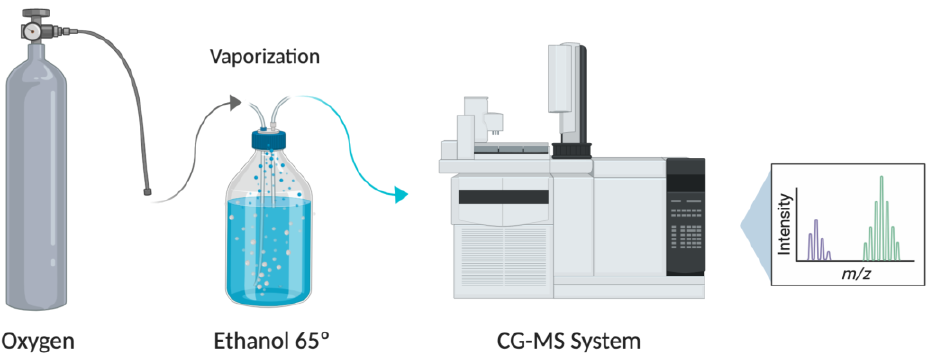
Figure 1. Diagram of the oxygen flow system and humidifier with 65° ethanol coupled to a gas chromatography mass spectrometry (GC-MS) system. Created with BioRender.com. Samples were incubated at 45 °C for 4 min, before 0.2 mL of headspace gas was with- drawn by the autosampler, using a 2.5 mL syringe heated at 50 °C. The gas volume was injected into the inlet of the Trace GC set at 175 °C in a constant temperature split mode, at a split ratio of 50:1 and the split flow of 50 mL/min. The analytical column was a Rxi- 624Sil MS, 30 m in length, with an internal diameter of 0.25 mm (1.4 μ m film thickness) from Restek (Pennsylvania, USA). Helium was used as carrier gas at a flow rate of 1.0 mL/min in a constant flow mode. The oven temperature was initially set at 40 °C for 4 min, then increased at a rate of 50 °C/min until 120 °C, and held at 120 °C for 2.5 min. The total runtime of each analysis was 10 min. The temperatures of the GC transfer line and the ion source of the MS were set at 220 °C and 200 °C, respectively. The mass spectrom- eter was operated in an electron impact ionization (EI+) mode, and the chromatograms were acquired in full scan mode over the m/z range of 20 – 150, from 2 to 10 min, at a scan rate of 3.55 scans/s. The chromatographic peak of ethanol was identified by comparison with reference spectra from the NIST 2011/Wiley 9 Combined Mass Spectral Library, us- ing NIST Mass Spectral Search Program (version 2.0), and confirmed by comparison of its retention time (3.4 min), with that obtained by analysis of authentic standard under the same conditions. The instrument control and data acquisition and processing were per- formed with Xcalibur 2.0.7 software (Thermo Fisher Scientific Inc., Waltham, MA, USA). The calibration curve of ethanol was prepared in 21.5 mL HS glass vials, which were previously sealed with Teflon septum caps, by adding different volumes of 99.5% (0.5 – 2 µL) ethanol to reach the headspace (vapor phase) concentrations in the range of 20 – 100 mg/L. The equation and determination coefficient obtained from three replicates were y = 82.285x + 9.8808 and R 2 = 0.9993, respectively. 2.3. Preclinical Studies 2.3.1. Ethanol Exposure Toxicological Studies and Immunohistochemical Analysis These studies were carried out on six female Sprague-Dawley rats (four receiving inhaled ethanol and two control rats). They were supplied by the animal facilities at the University of Santiago de Compostela, and the average weight was 250 ± 25 g. During the experiments, animals were kept in individual cages under a controlled temperature (22 ± 1 °C) and humidity (60 ± 5%) conditions, with day-night cycles regulated by artificial light (12/12 hours) and fed ad libitum . All animal experiments complied with the ARRIVE guidelines [31] and were carried out in accordance with the EU Directive 2010/63/EU for animal experiments, being approved by the Galician Network Committee for Ethics Re- search. All experimental procedures were approved by the ethical committee and the local authorities before conducting experimental work. For the administration, 65° ethanol was placed in a disposable humidifier and vapor- ized by passing an oxygen flow of 2 L/min. The generated ethanol vapors went through a